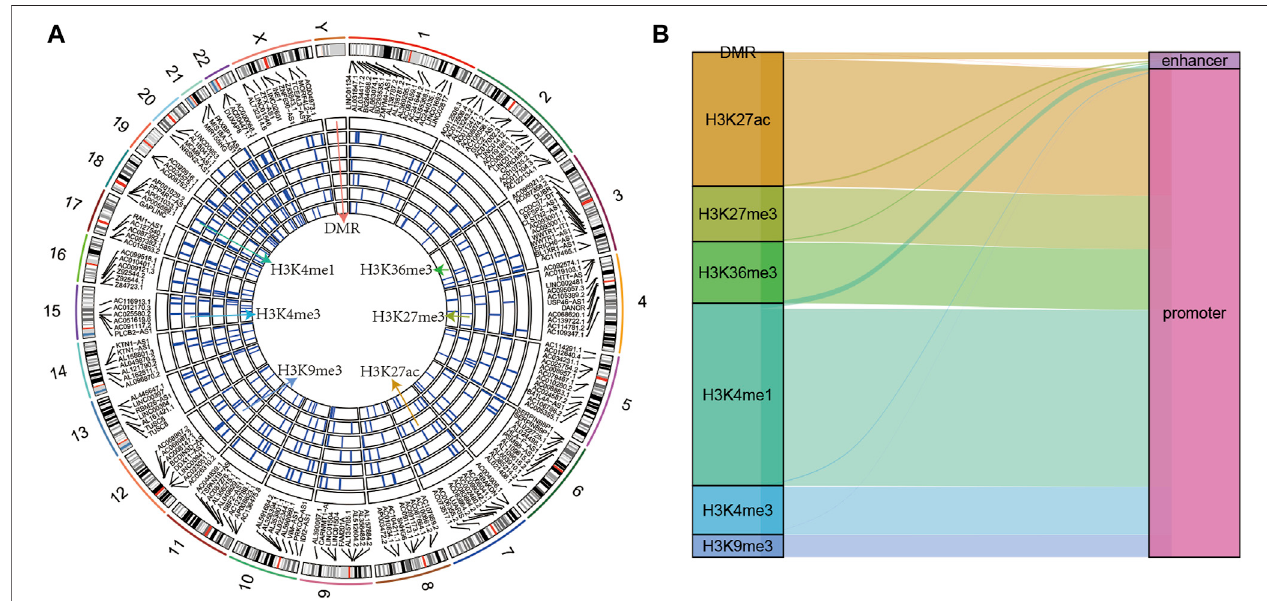
FIGURE 2 | (A) Genomic landscape of epi-lncRNAs having differential histone modi fi cations and differential methylation regions; (B) Type distribution of epi- lncRNAs having differential apparent